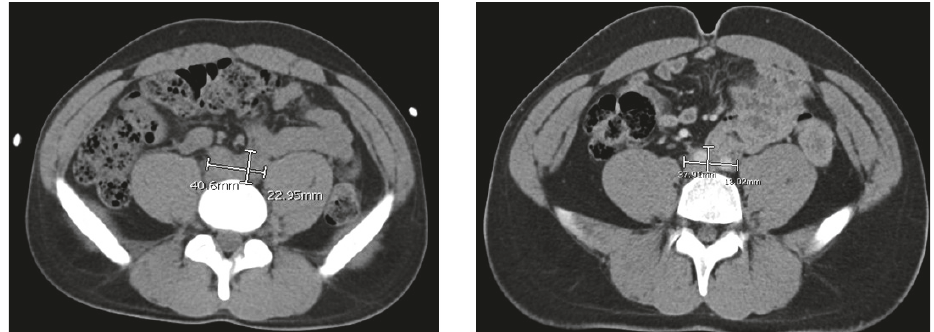
Figure 3: Follow-up abdomen and pelvis computed tomogram with and without intravenous contrast 4 months following a course of corticosteroid therapy revealed significant reduction in the soft tissue mass (approximately 4 cm in diameter compared with 7 cm at presentation).